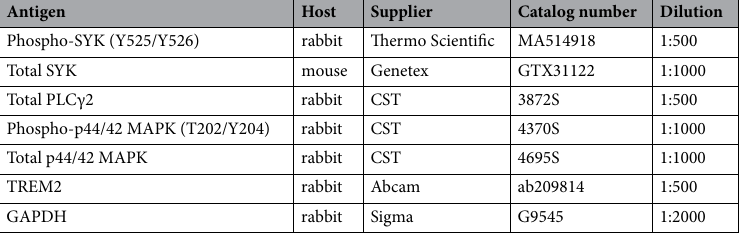
Table 1. Membranes were washed in TBS/0.1% Tween20 and further incubated with an HRP-labelled anti-rabbit IgG or anti-mouse IgG (Thermo Scientific) for 1 h at RT. Membranes were incubated with the SuperSignal West Dura Extended Duration Substrate (Thermo Scientific) and signal was detected on the FujiFilm LAS-4000 System (Raytek). Intensity of protein bands was quantified using ImageJ 1.52a software. Calcium assay.